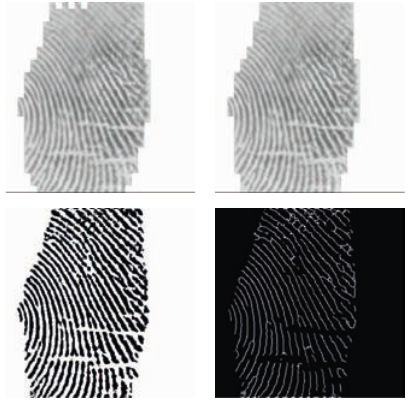
Figure 7. Upper row: output of local feature level (left), result of post-processing (right). Lower row: segmented image by local threshold (left), applying thinning